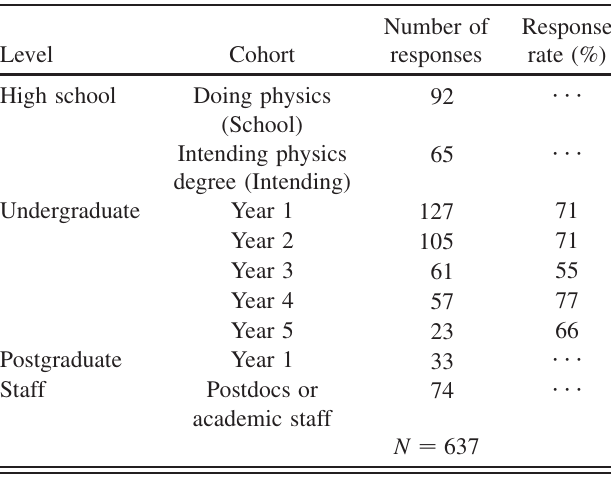
TABLE I. Summary of survey responses by cohort and re- sponse rate for undergraduate